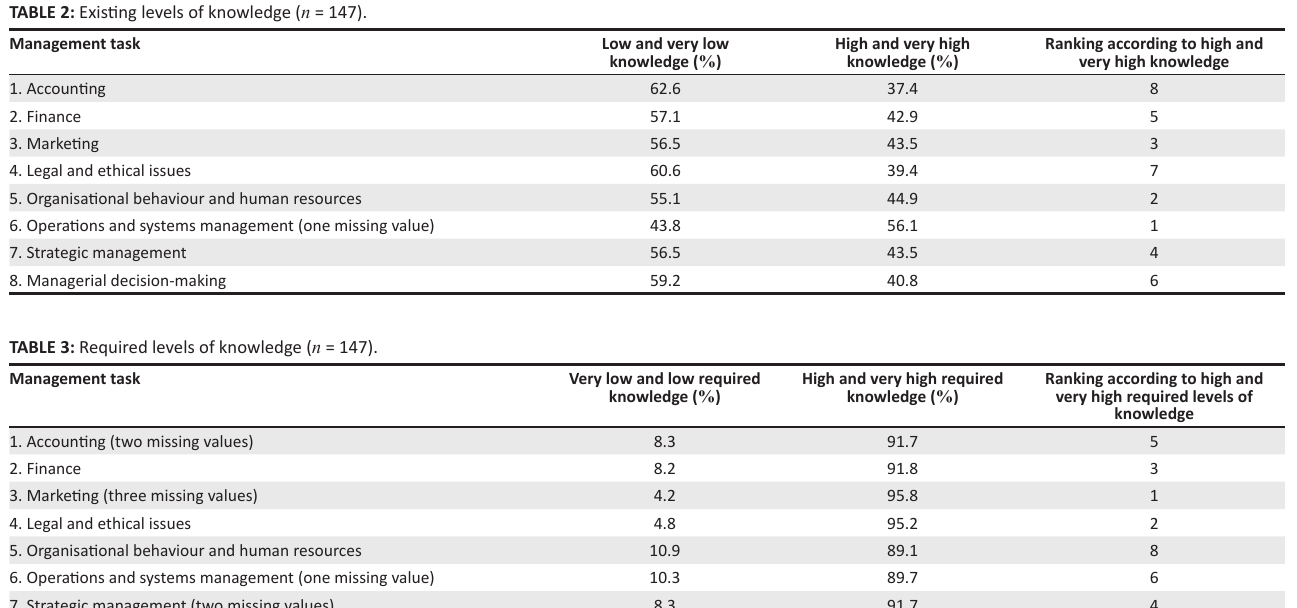
High and very high knowledge ( % ) knowledge ( % )